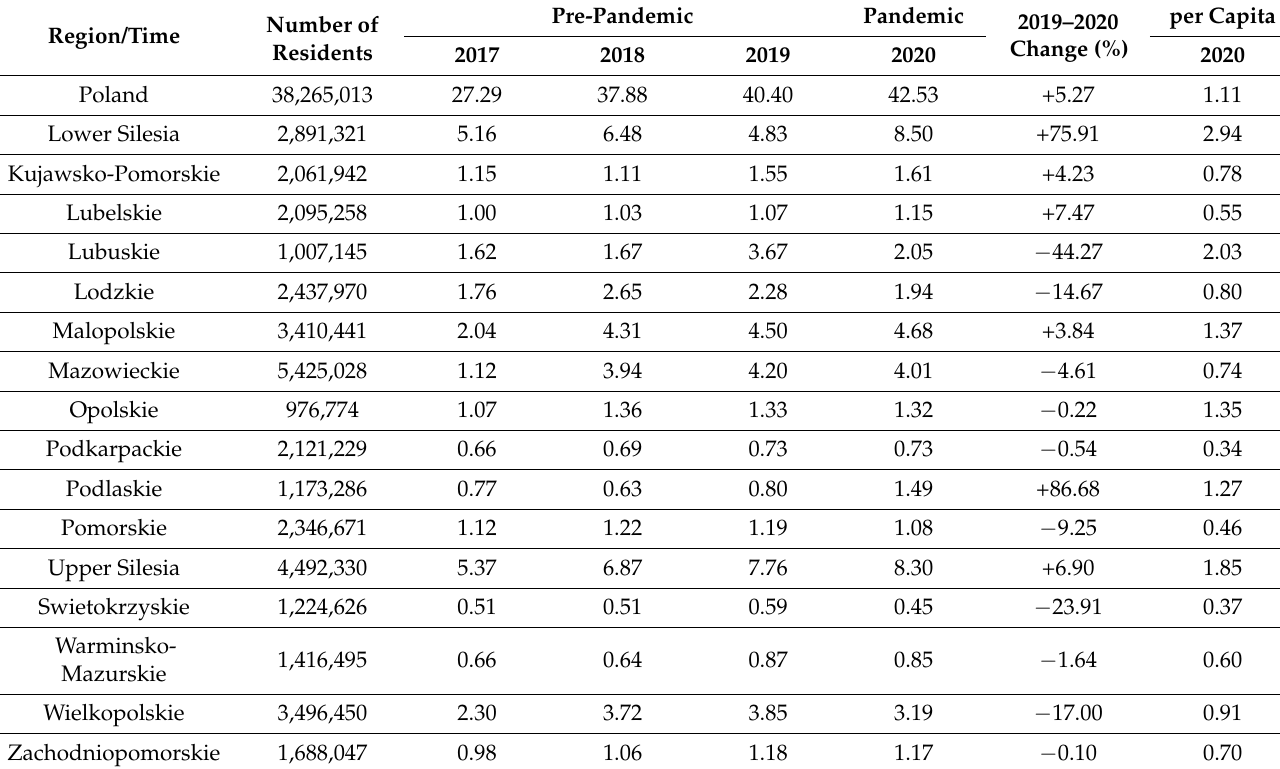
Table 2. Local government expenditure on physical culture in Poland by region in 2017–2020 (total in million euros and per capita in